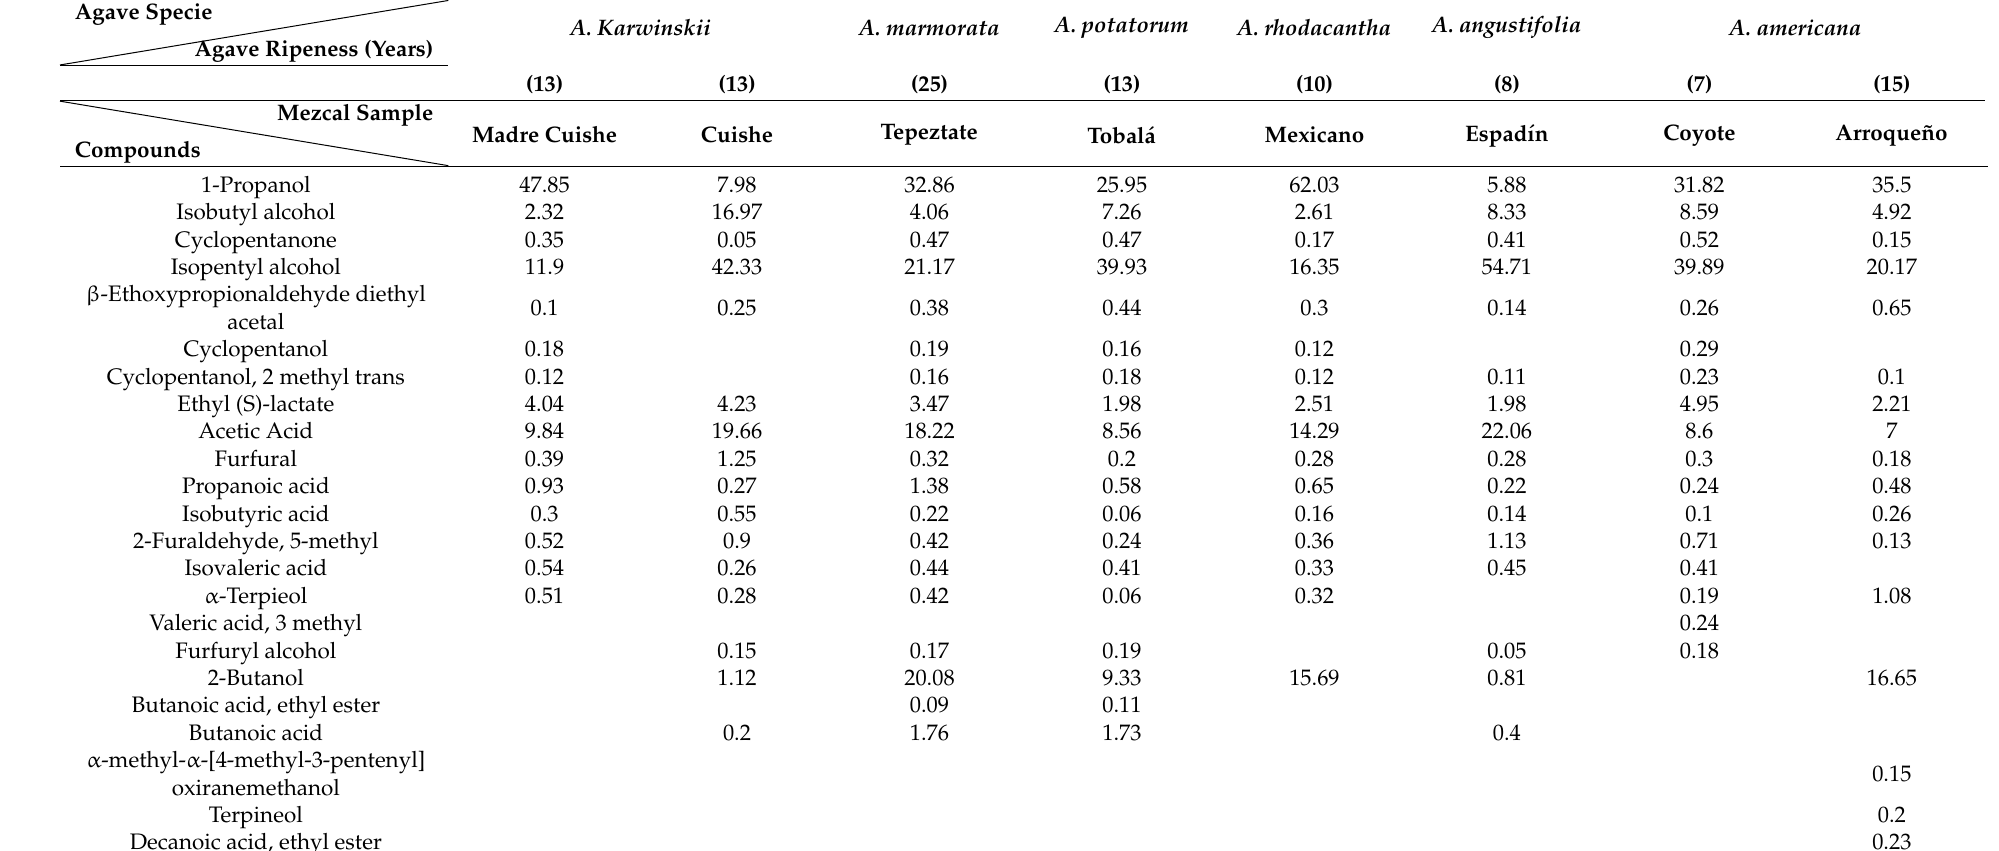
Table 1. Relative abundances of volatile compounds in mezcal by different Agave origins of the eight mezcals analyzed. Agave